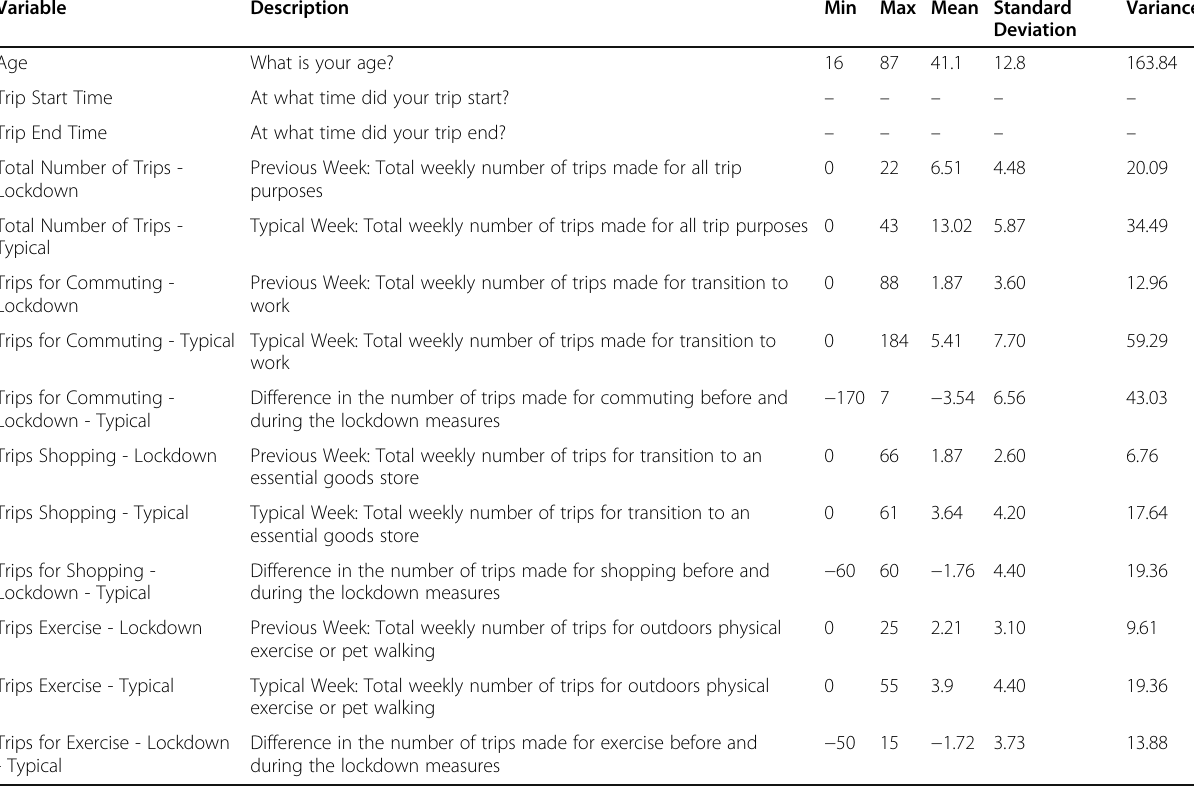
Table 5 Descriptive characteristics of main scale